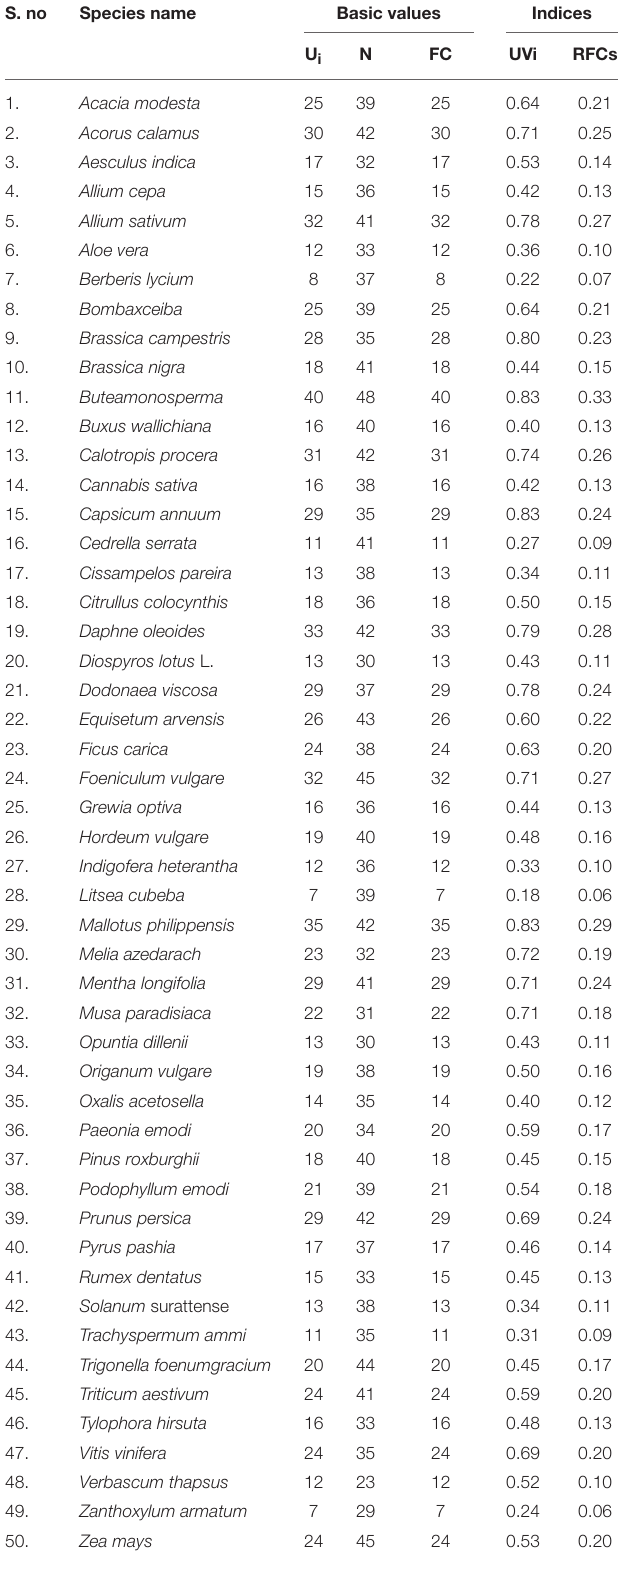
TABLE 4 | Quantitative analysis of the medicinal plants of Chamla Valley, KP, Pakistan. S. no